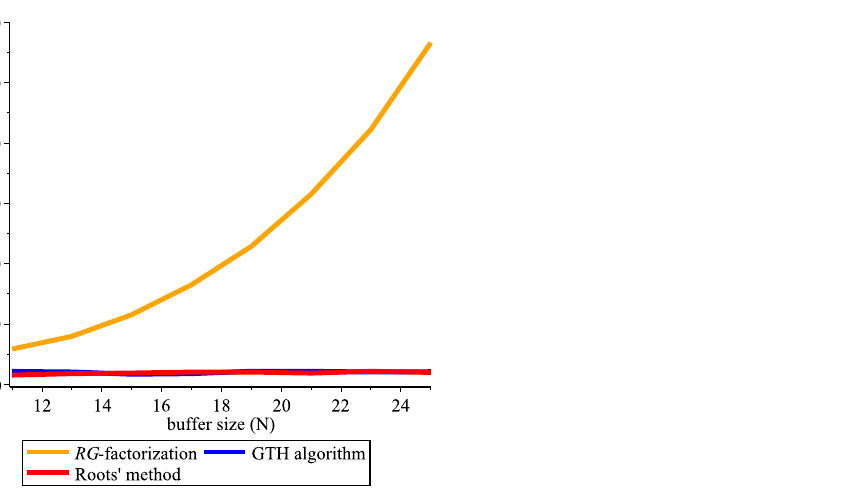
Figure 7. Computation time for different techniques with varying number of